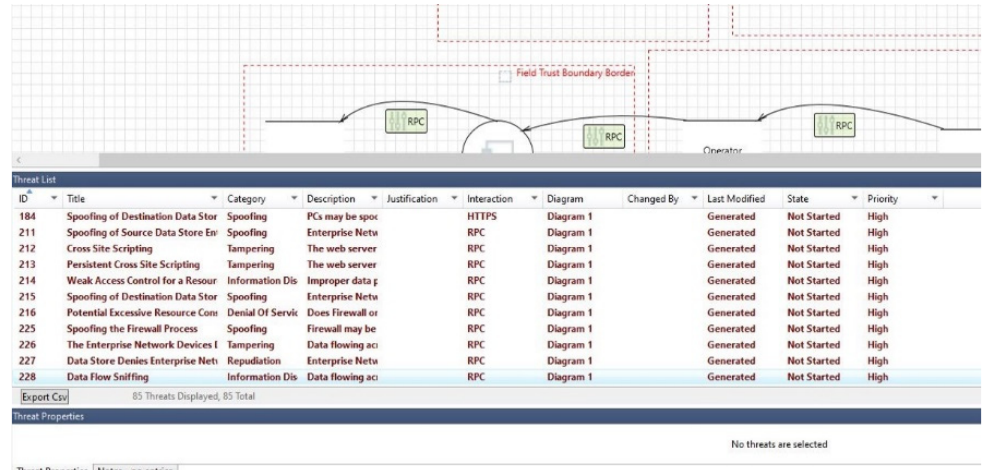
Figure 8. An image of the threat list in the MTMT program.